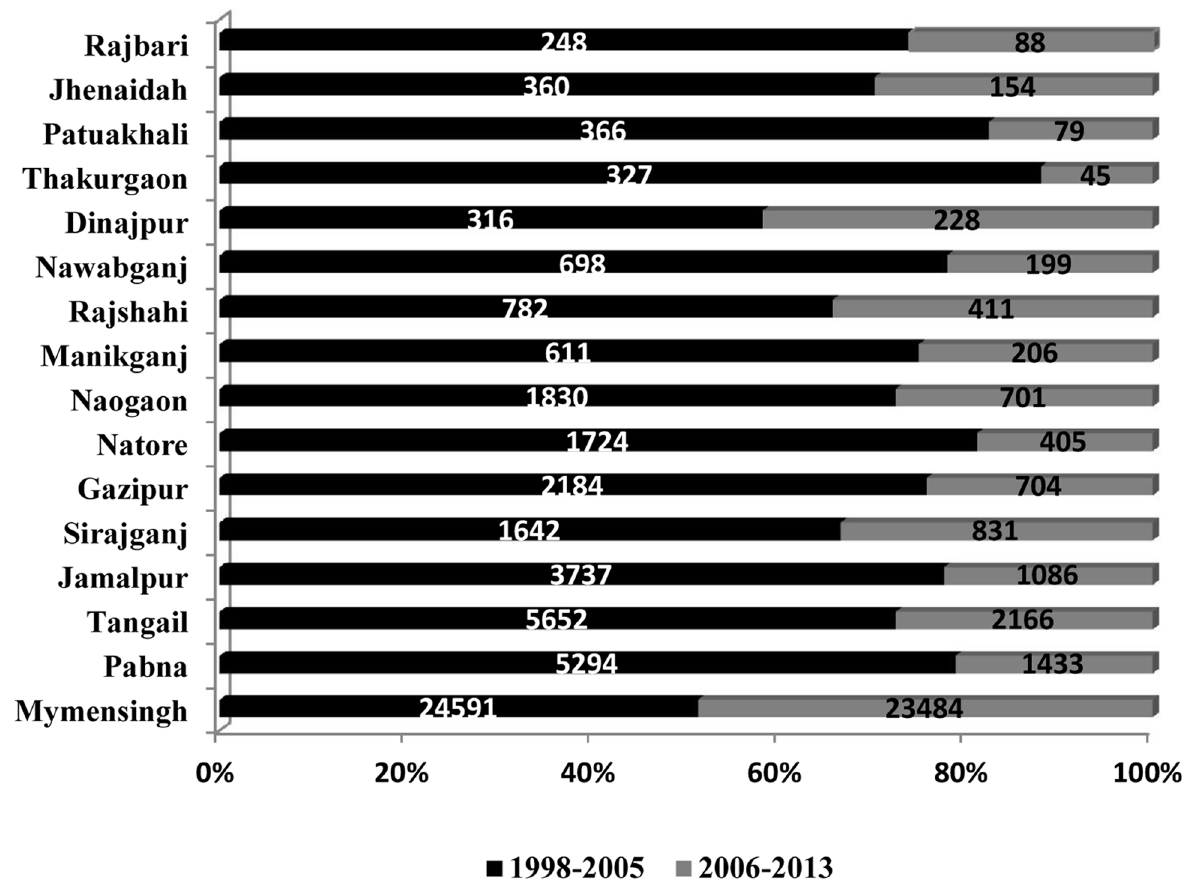
Figure 3. Comparison of the percentage-wise share in the total number of VL cases per district for the period of eight years before (1998–2005) and after (2006–2013) signing the memorandum of understanding by the Health Ministers from Bangladesh, India, and Nepal to eliminate VL from their respective countries by 2015. Source: Malaria and Vector-Borne Disease Control Unit, Directorate General of Health Services (DGHS), Dhaka, Government of Bangladesh.